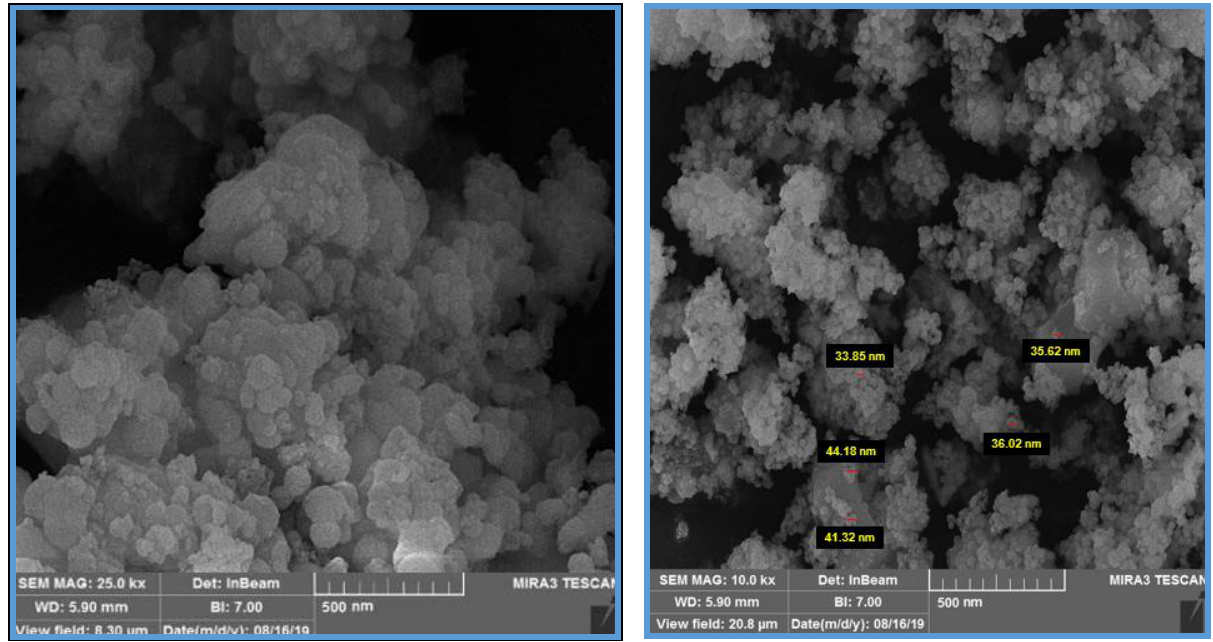
Figure 11. SEM image of recovered Mn-supported nano-catalyst.